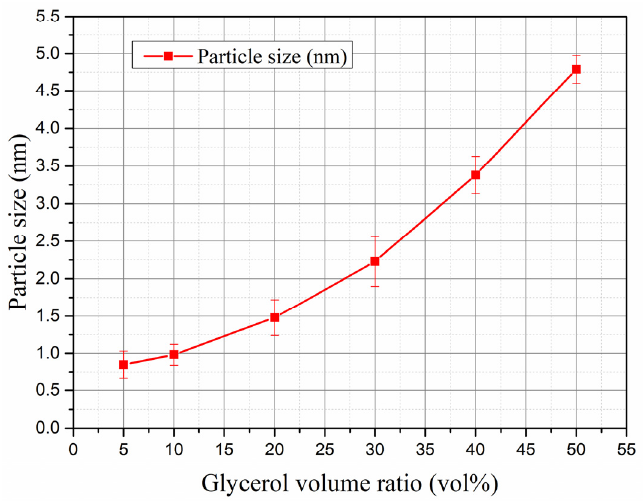
Figure 1. Variation of particle size of mixed fuel with different volume ratios of glycerol (anhydrous substances were used for the fuel components).